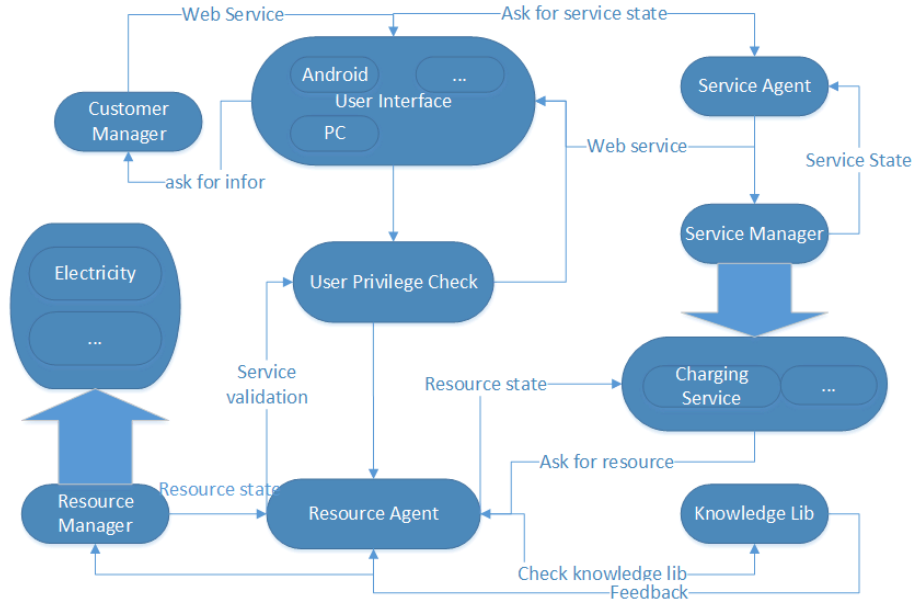
Figure 4. Design of the charging request of plug-in hybrid electric vehicles